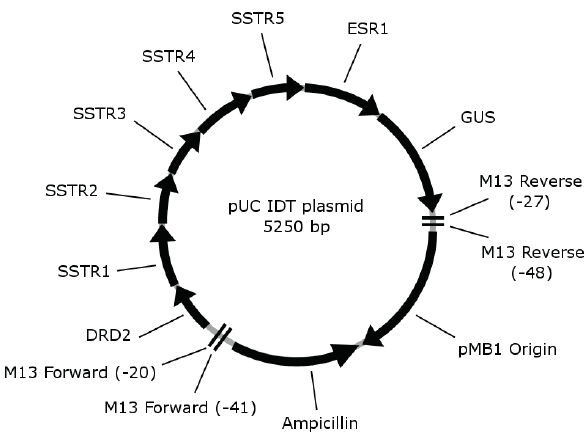
Fig. 1. Alignment of the inserted synthetic sequences in a pUC IDT cloning